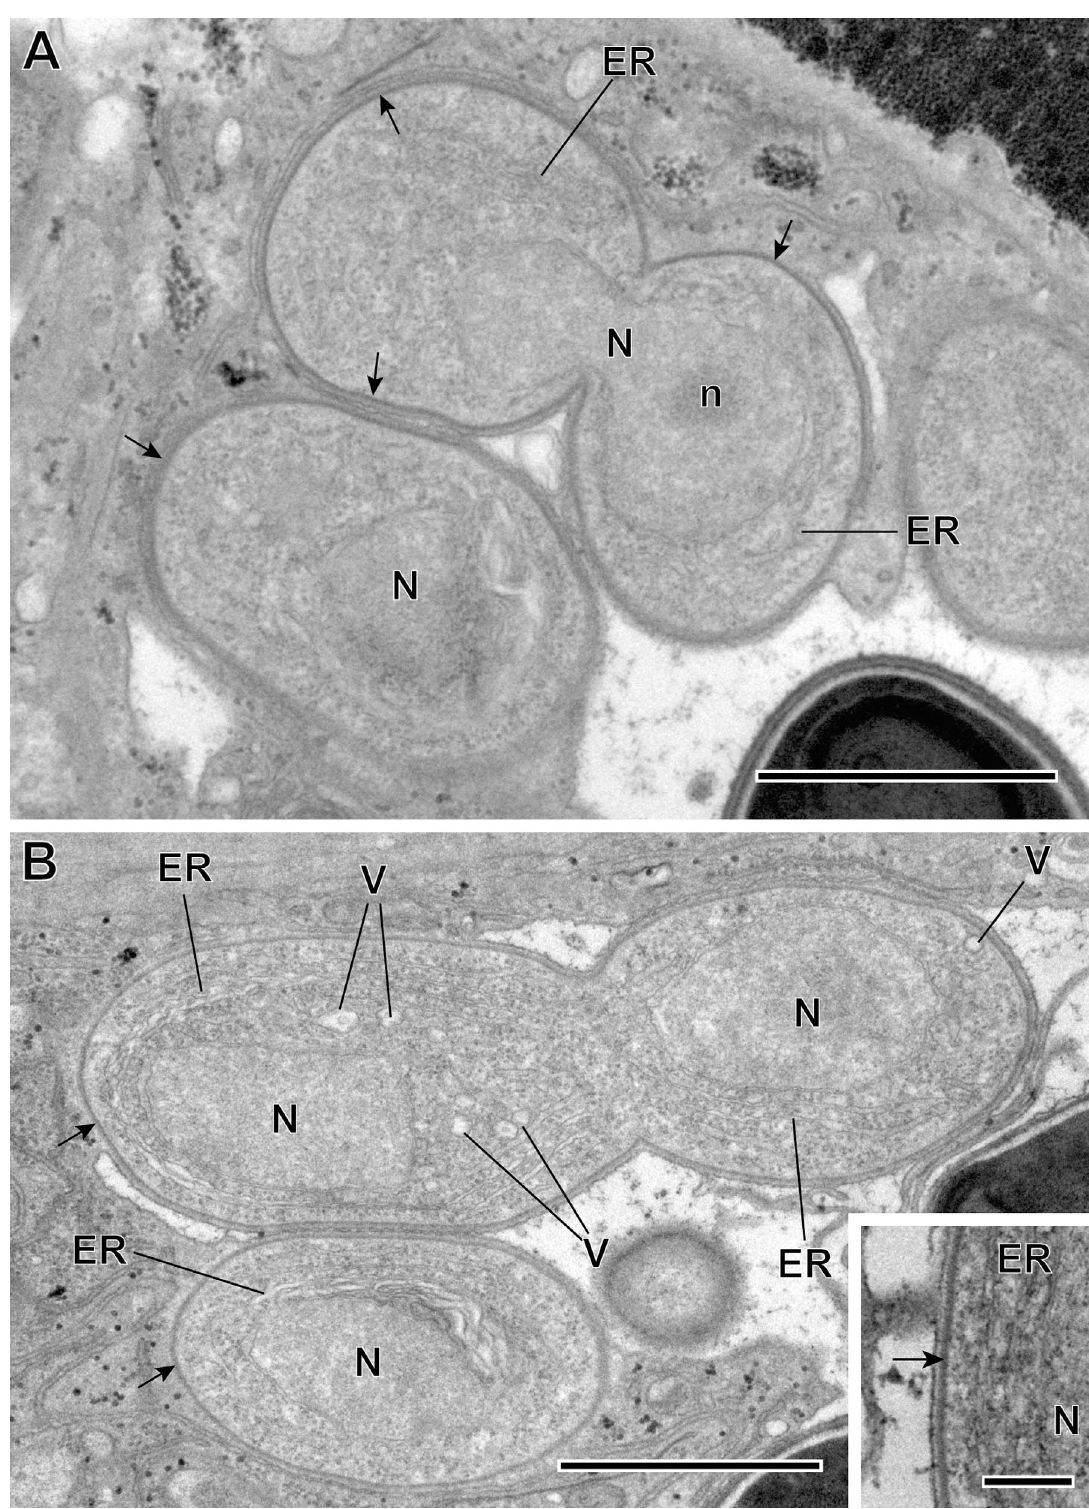
Figure 5. (A – B) Sporogonic stage of Toguebayea baccigeri n. gen., n. sp. Note the thick membrane of sporonts (black arrows) in comparison with meronts; (inset) Detail at high magni fi cation of the sporont plasma membrane (black arrow). ER, endoplasmic reticulum; N, nucleus; n, nucleolus; V, vacuoles. Scale bars: A – B = 1 l m; inset = 0.2 l